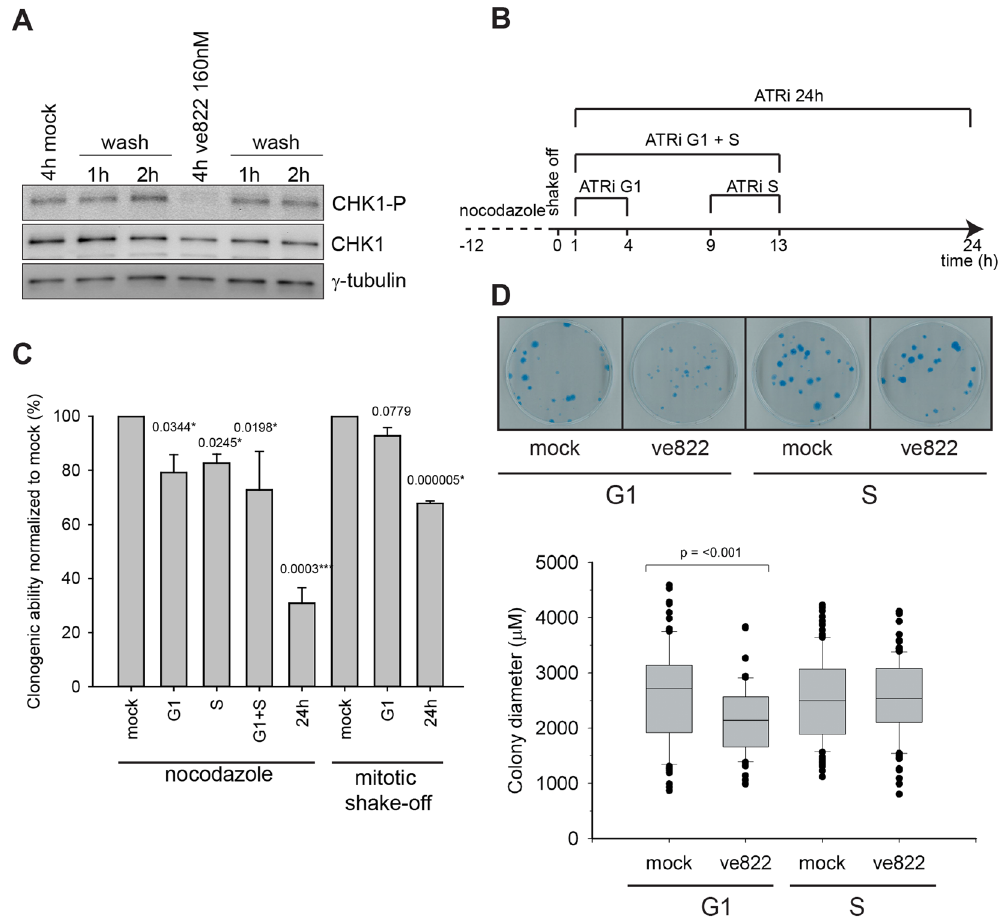
Figure 6. Responses to ATR inhibition in G1 phase. ( A ) Immunoblot showing the presence of CHK1-P (S345) in total cell extracts of U2OS cells treated with ATRi ve822 (160 nM) in G1. Inhibitor or DMSO (mock) was added 1 hour after release and washed out 4 hours later by exchanging the medium with fresh medium 3 times. Cells were harvested at the end of ATR inhibition (4 hours) and 1 and 2 hours after removal of inhibitor (wash). Total CHK1 levels are shown for comparison and γ -tubulin is shown as loading control. Full-length blots are presented in Supplementary Fig. S7. ( B ) Schematic description of the experiment shown in C and D. ( C ) Clonogenic survival of U2OS cells after inhibition of ATRi in one G1- or S-phase, G1 and S-phase combined or 24 hours as illustrated in B. Treatment was applied 1 hour after seeding and release from mitotic arrest (G1, G1 + S and 24 hour treatment). S-phase treatment was applied 9 hours after release. After treatment inhibitor or DMSO (mock) was removed as denoted above in A and the dishes were cultured further for 14 days. Relative survival is normalized to 100% for mock. Error bars are indicated as standard deviations of three independent experiments. Numbers are p-values obtained from a two-tailed t-test. ( D ) Photographs show representative dishes from each treatment. Box plots show colony diameter of U2OS cells after the clonogenic assay performed in B. The colonies were measured 14 days after release from nocodazole arrest and treatment. Horizontal bars are median, upper and lower edges of box are at 75th and 25th percentiles, lines extending from box are 90th and 10th percentiles. Single dot shows 95 th and 5 th percentiles. Each box represents 70–110 measurements. Median latencies between groups mock (G1) and ve822 (G1) were 2715.28 and 2139.61 µ M; the distributions in the two groups differed significantly (Mann–Whitney U = 2225, n 1 = 68 n 2 = 95, P <